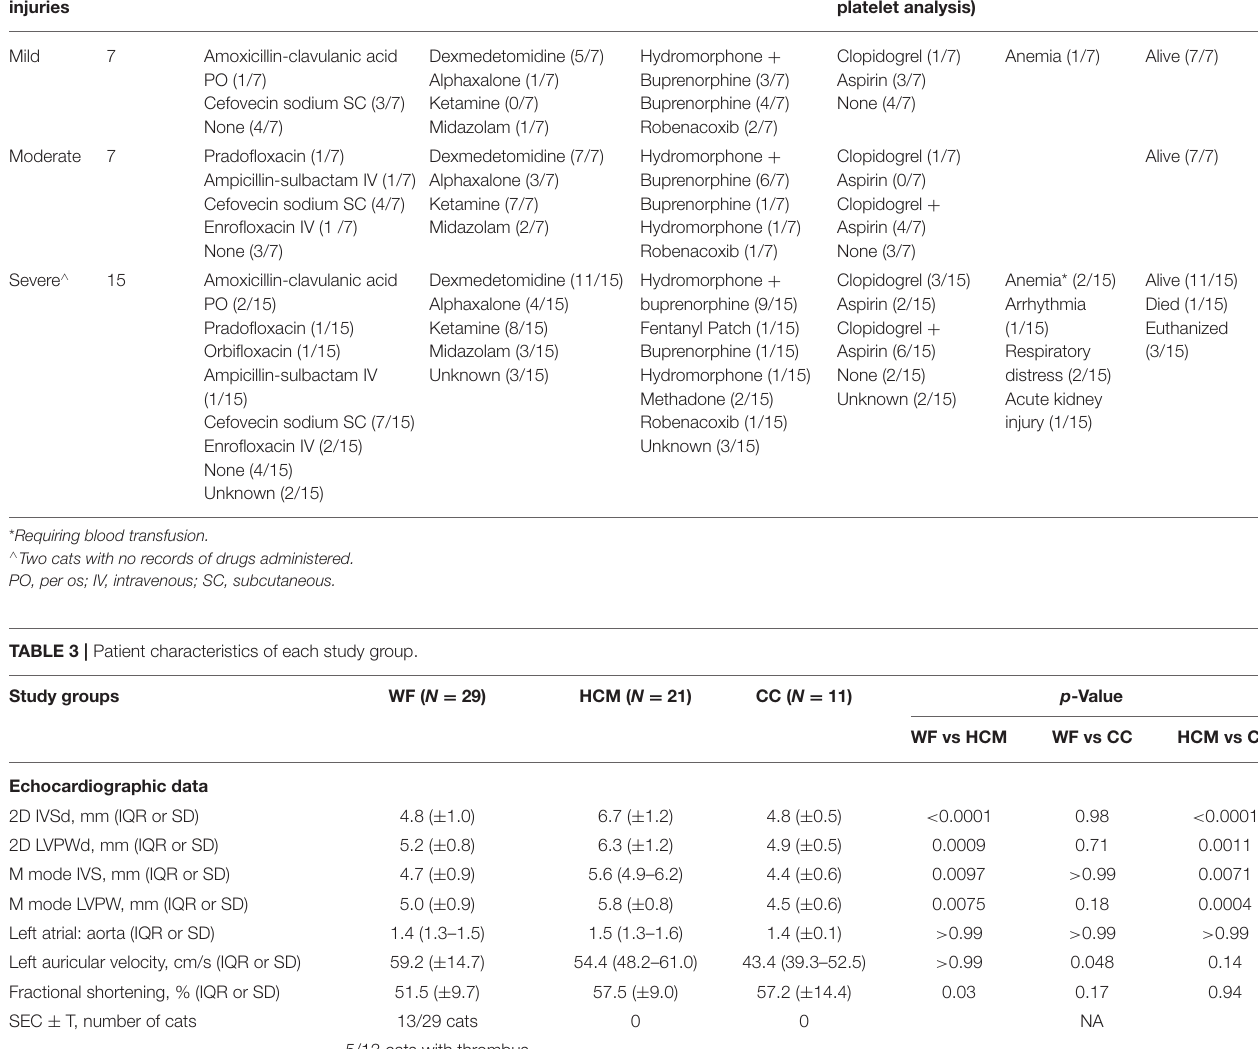
Co-morbidity Outcome (started following platelet analysis)